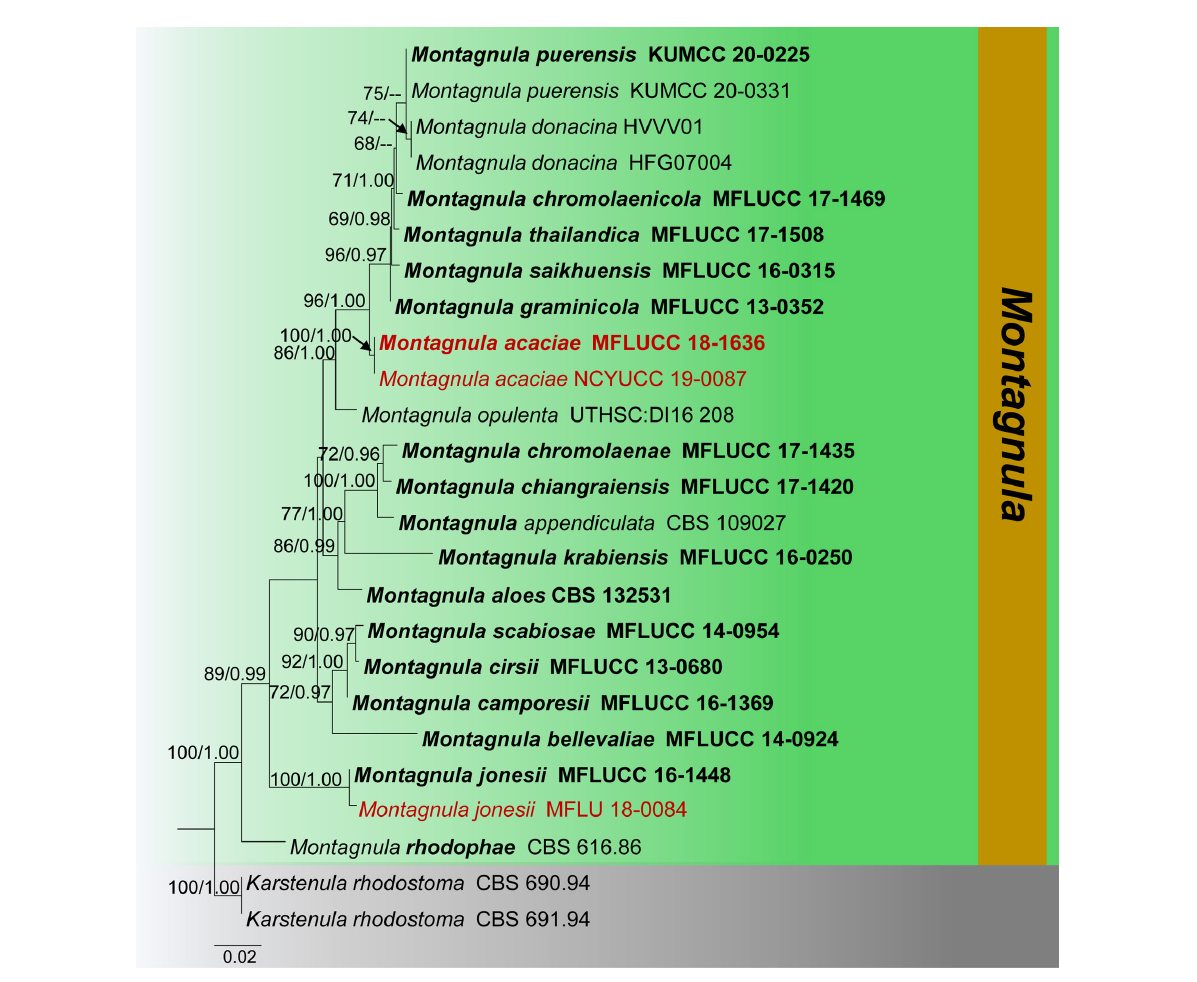
FIGURE2 Phylogram generated from maximum likelihood analysis is based on combined ITS, LSU, and SSU sequence data (Final likelihood value of − 9216.328354). The tree is rooted with Karstenula rhodostoma (CBS 690.94 and CBS 691.94). The ex-type strains are indicated in bold, and the new isolates are indicated in red. Bootstrap support values ≥ 65% from the maximum likelihood (ML) and Bayesian posterior probabilities (PP) values ≥ 0.90 are given above the